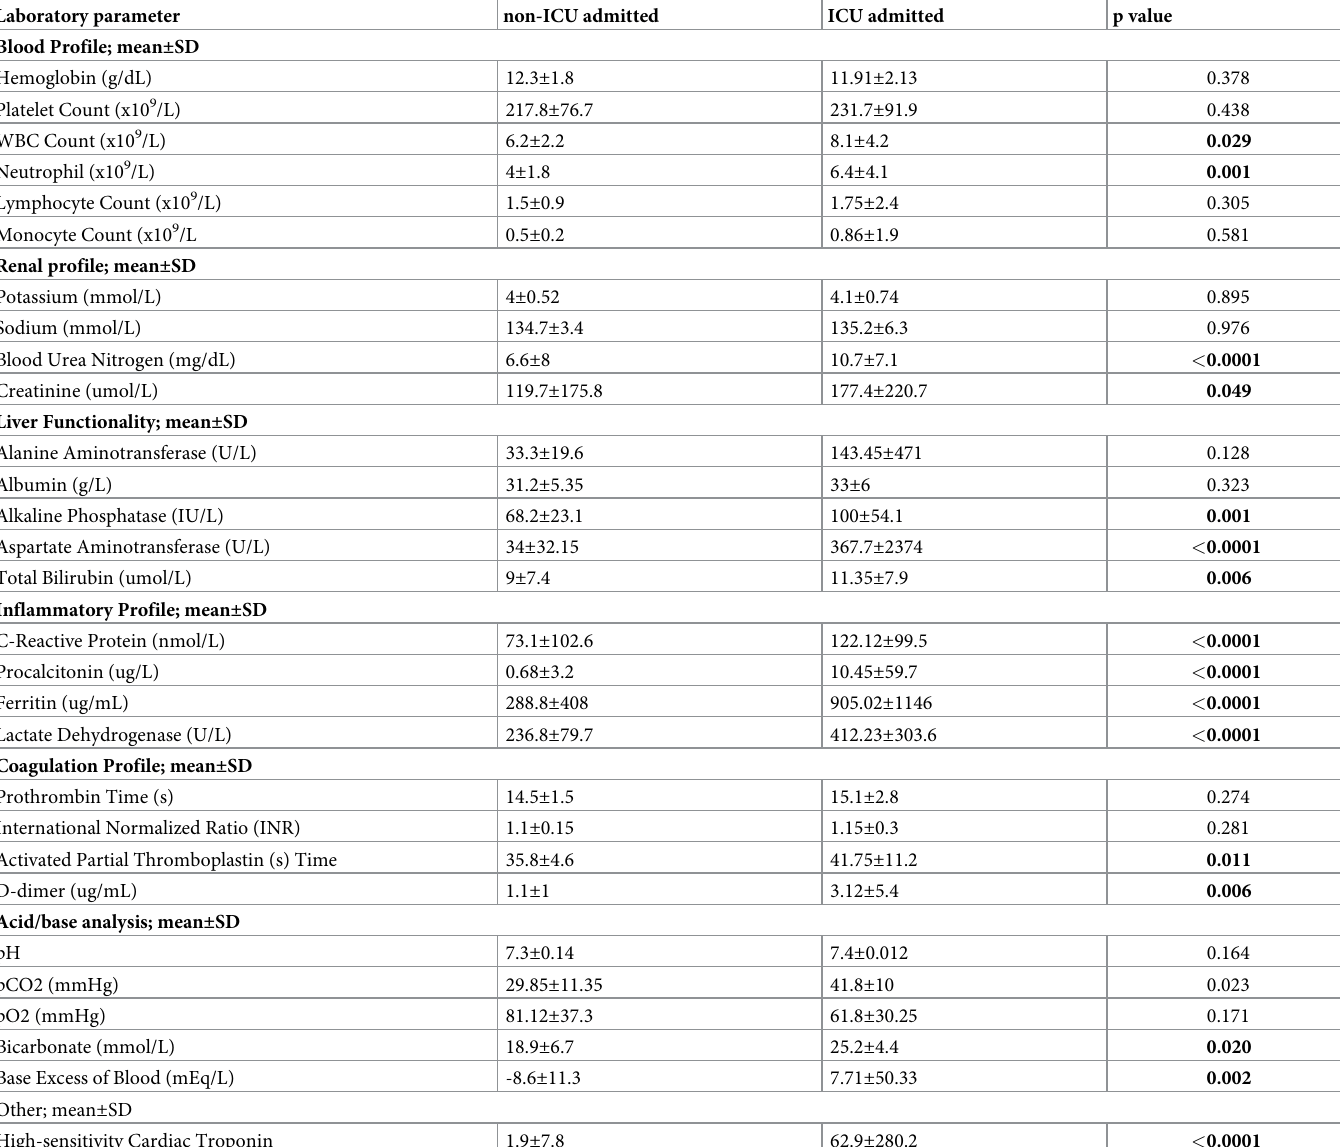
Table 4. Biochemical and laboratory findings of the COVID-19 positive patients demarcated into non-ICU and ICU admitted. Laboratory